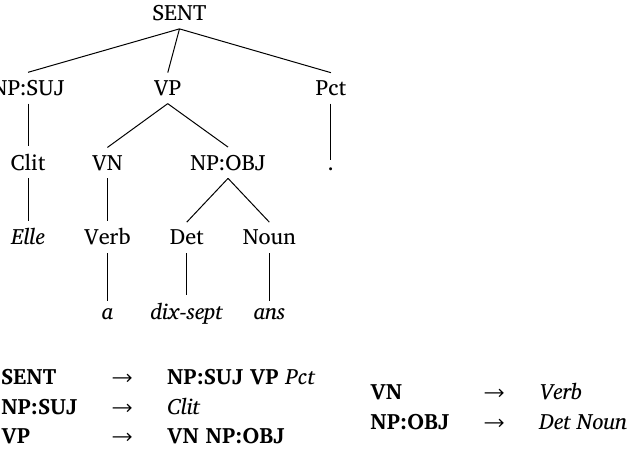
Figure 3: Constituent tree and inferred CFG